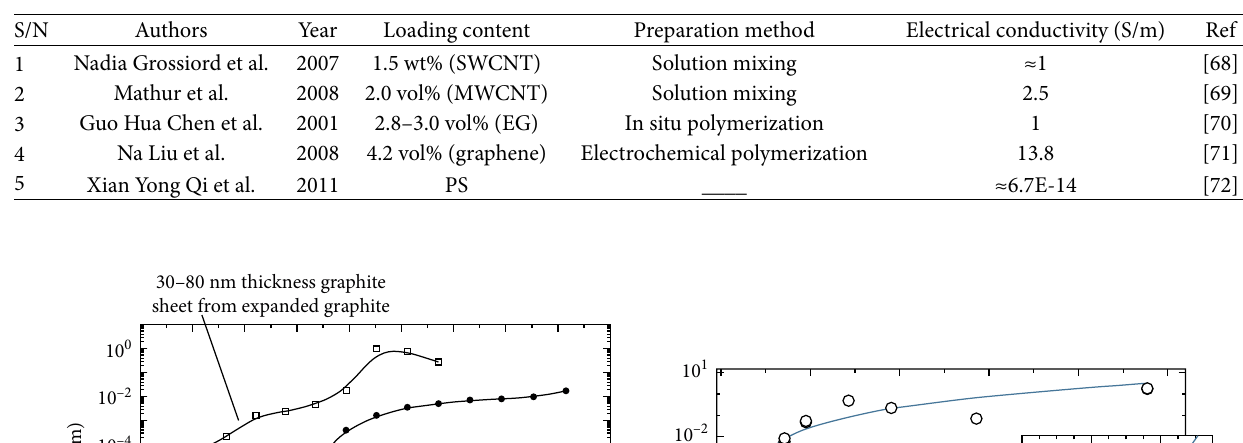
Table 1: Electrical conductivity enhancement in PS polymer nanocomposites.